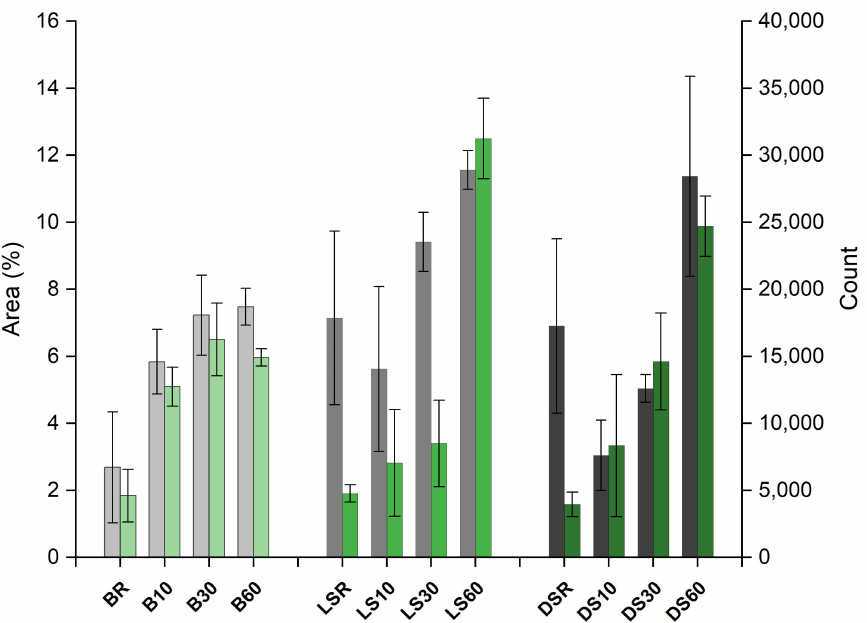
Figure 10. Cracked area (%, in grey) per total surface area and number of cracks (count, in green) as analyzed by ImageJ. B = birch, LS = light spruce, DS = dense spruce, R = reference; modified for 10, 30 and 60